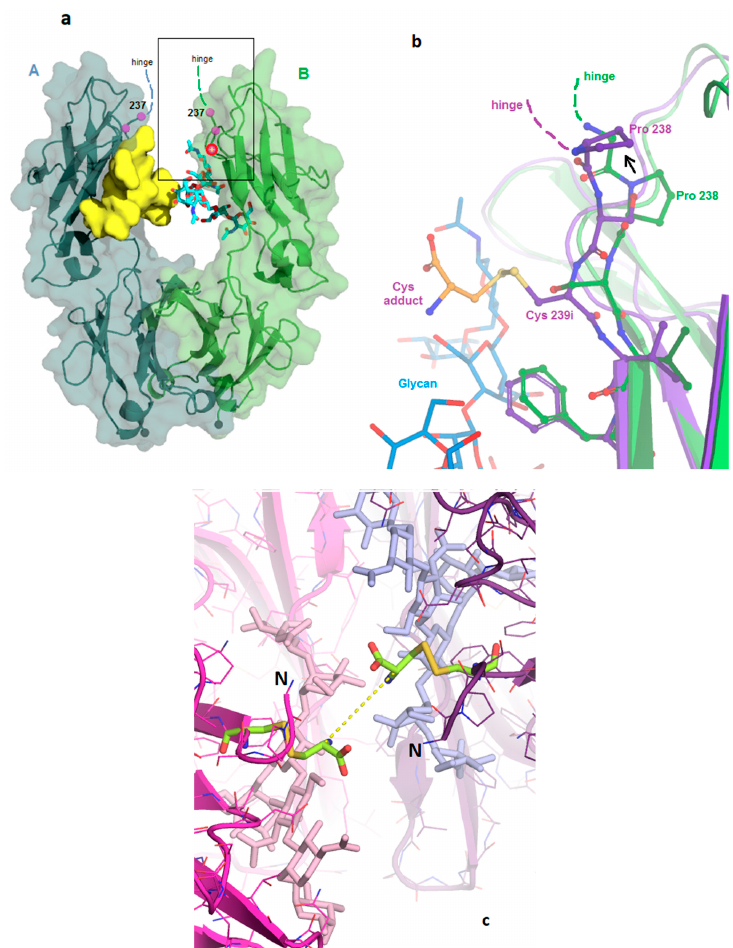
Figure 1. Fc-C239i structure. ( a ) Wild-type Fc showing the area of the inserted cysteine. Glycans are shown using a yellow surface for the A-chain and cyan sticks for the B-chain. The location of glycine 237 is indicated in both chains, and the location of serine 239 in the B-chain is shown with a yellow cross and red circle. The rectangle corresponds to the zoomed-in region of ( b ). ( b ) Structural effects of the inserted cysteine. Superposition of the C239i protein (purple, PDB:6P6D) onto wild-type (green, PDB:5VGP) in the region of the inserted cysteine, to which an extra cysteine (adduct, gold colors) is bound by a disulfide. The inserted cysteine 239i occupies the location held by Ser 239 in the wild-type. This displaces the serine upward, causing Pro 238 also to shift upward (arrow). ( c ) View down the molecular dyad of Fc-C239i into the solvent cleft, with the A-chain in magenta and the B-chain in purple. All four Cys residues are colored green (each chain has its Cys 239i insertion, and each of these carries a disulfide-linked cysteine adduct). N termini (labeled with ‘N’) are to the left and right of the center. Glycans are visible just beyond the cysteines (pink and blue sticks). The central dashed line shows the 0.7 nm distance between the alpha carbons of the two adducts across the